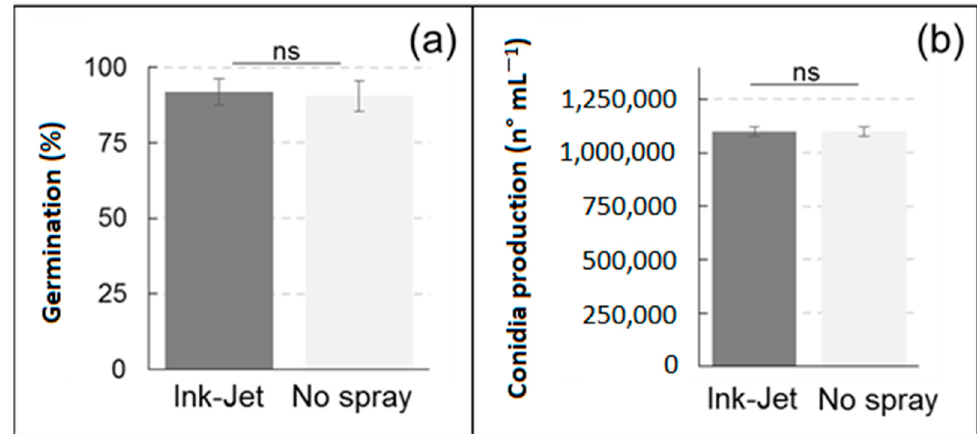
Figure 4. Spore germination ( a ) and conidia production ( b ) of Coniothyrium minitans in relation to treatment with the ink-jet spray system. Data are means ± standard deviation, ns = statistically insignificant difference (Duncan’s test).